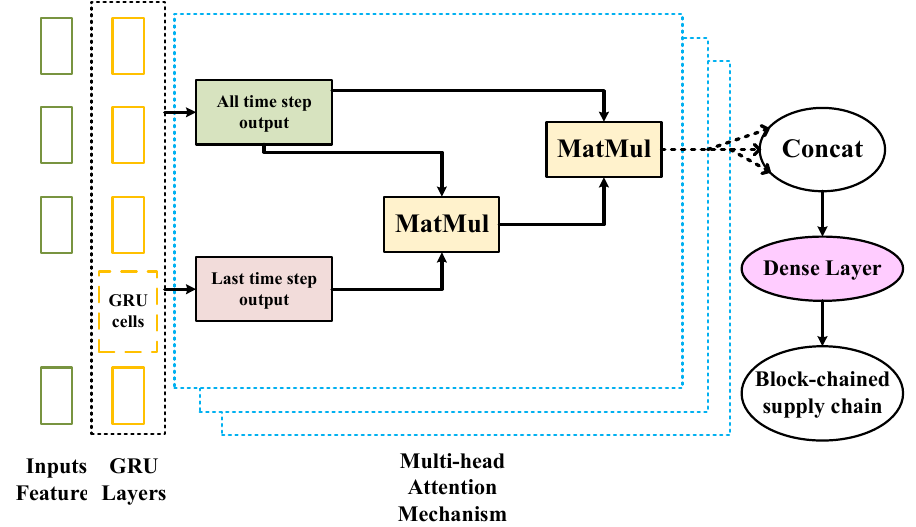
Figure 9. Structure of Multi-Head Attention GRU model.